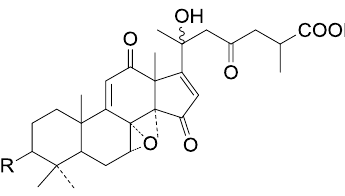
Figure 32. Structures of compounds 281 – 282